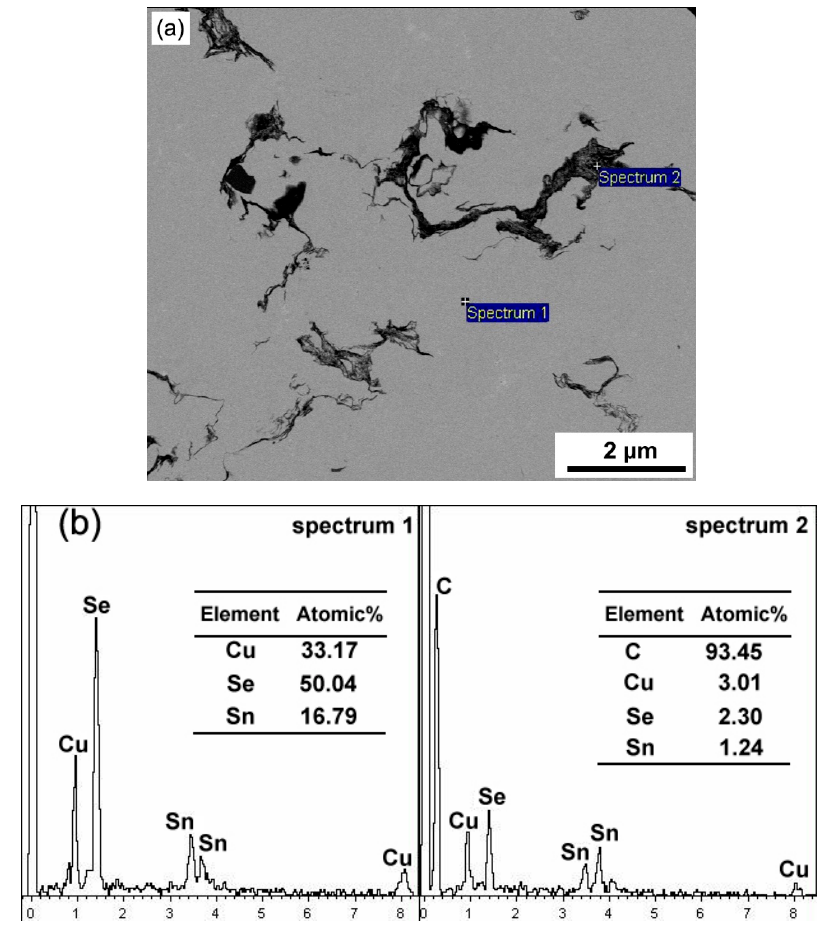
Figure 5. ( a ) SEM image of the sintered 1.0% graphene/Cu 2 SnSe 3 composite; ( b ) energy dispersive X-ray spectroscopy (EDS) analysis.